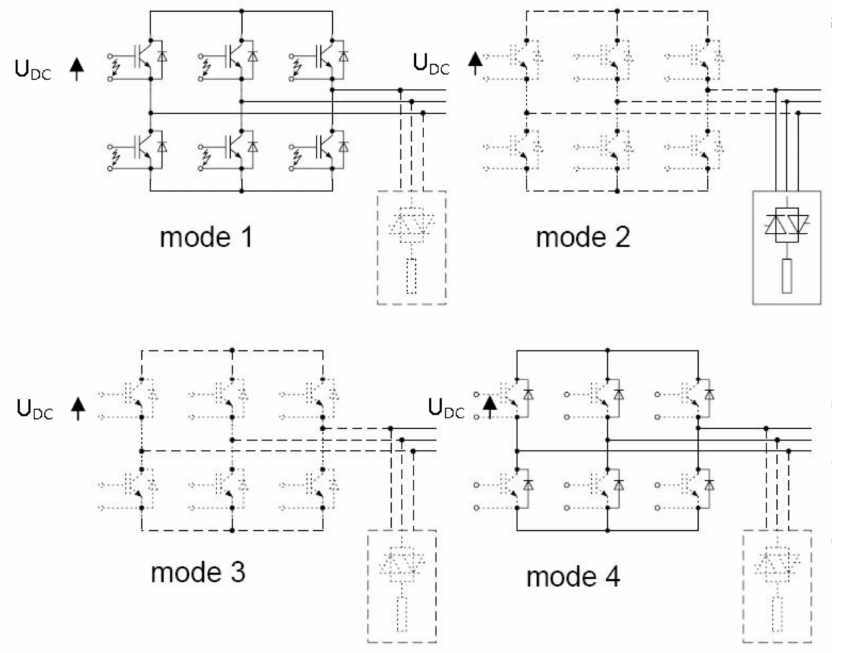
Figure 5. The four operation modes of the crowbar